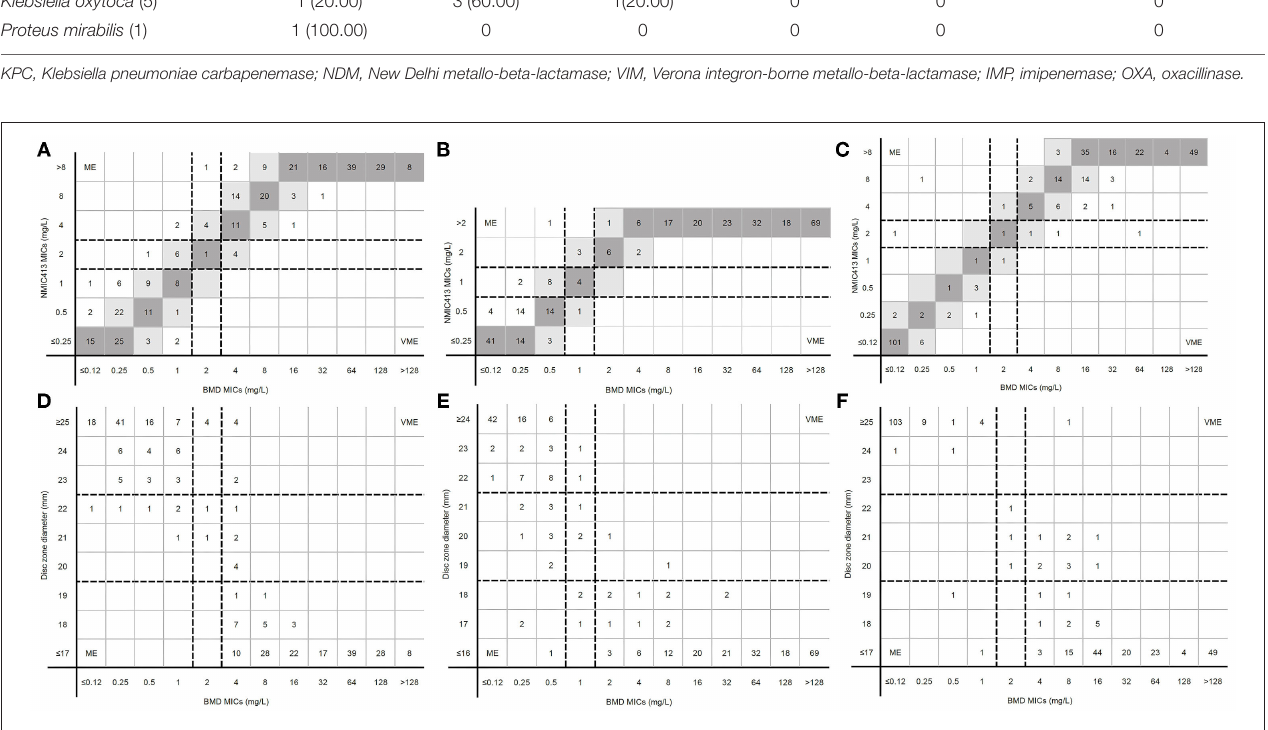
FIGURE 3 | MICs determined by BD Phoenix NMIC-413 panel, disk diffusion and broth microdilution. (A) (imipenem), (B) (ertpenem), and (C) (meropenem) were the results of BD Phoenix NMIC-413 vs. broth microdilution; (D) (imipenem), (E) (ertpenem), and (F) (meropenem) were the results of disk diffusion vs. broth microdilution. Dark gray expresses identical MIC, and light gray indicates 2-fold difference between the BMD and NMIC-413 panel MICs. Dotted lines show the clinical breakpoints for each